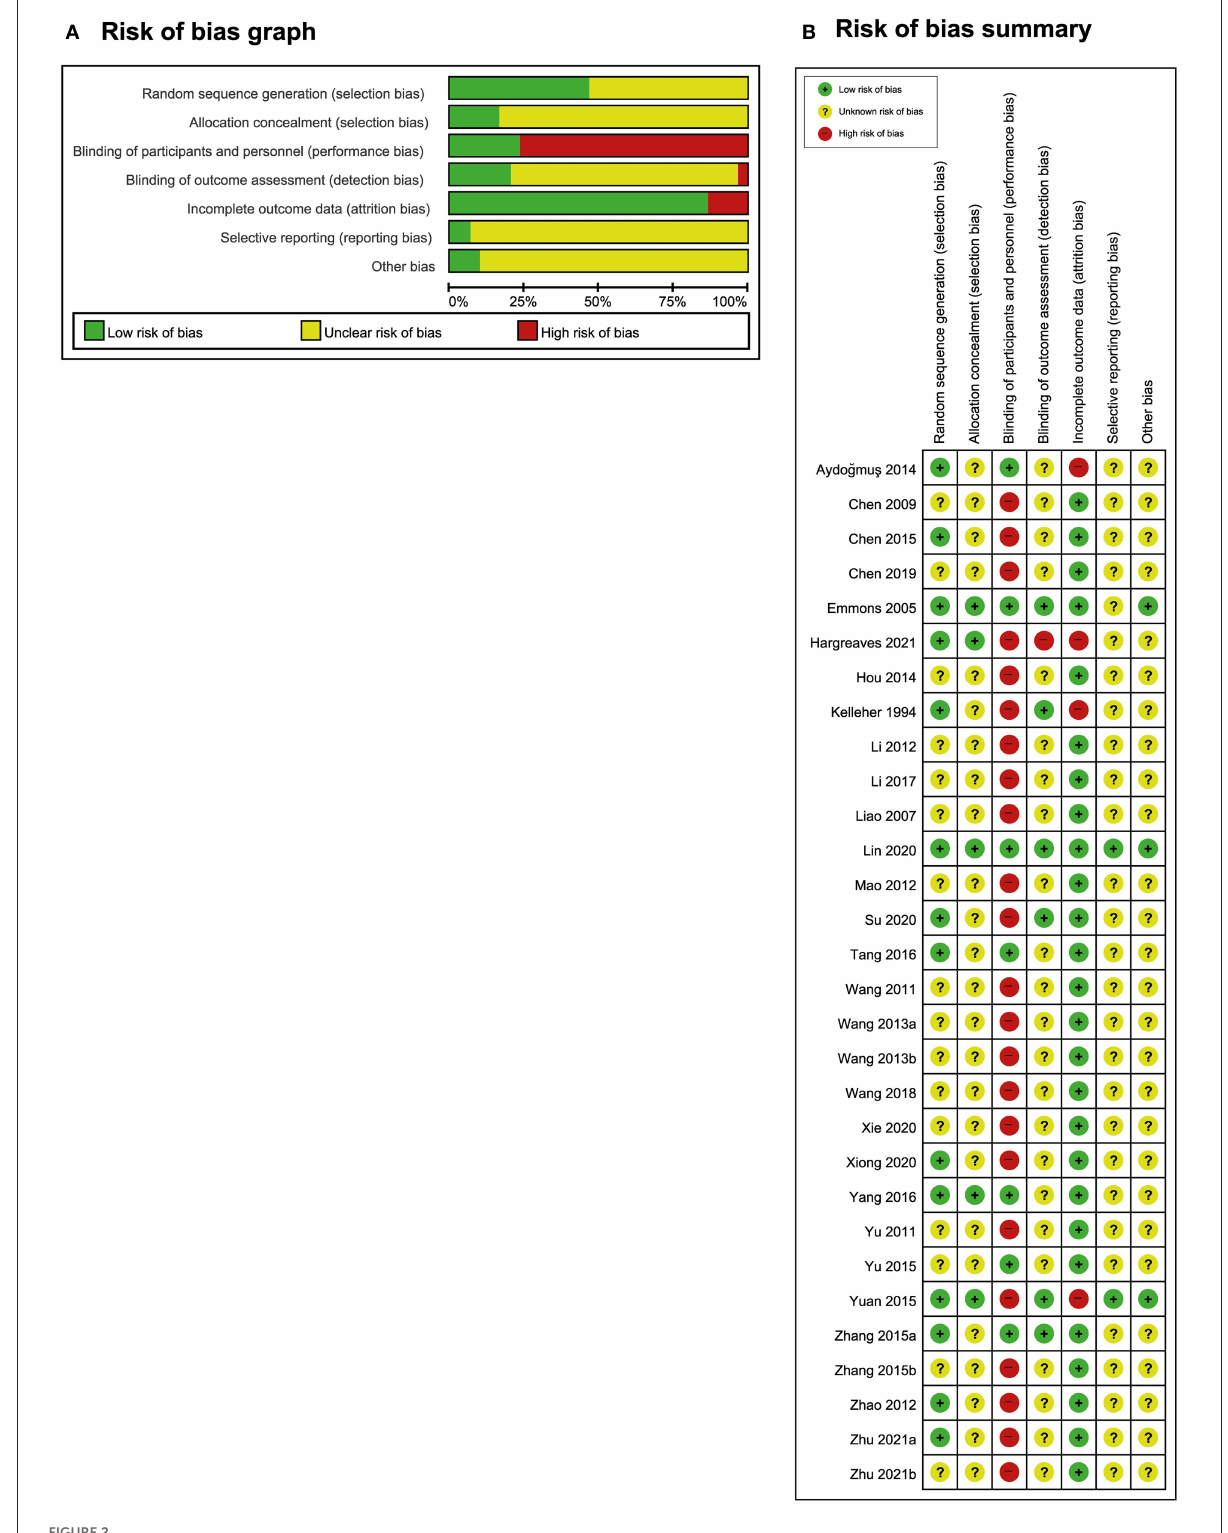
FIGURE2 Risk of bias. (A) Risk-of-bias graph and (B) risk-of-bias summary: The present authors’ judgments regarding the risk of each form of bias in all included